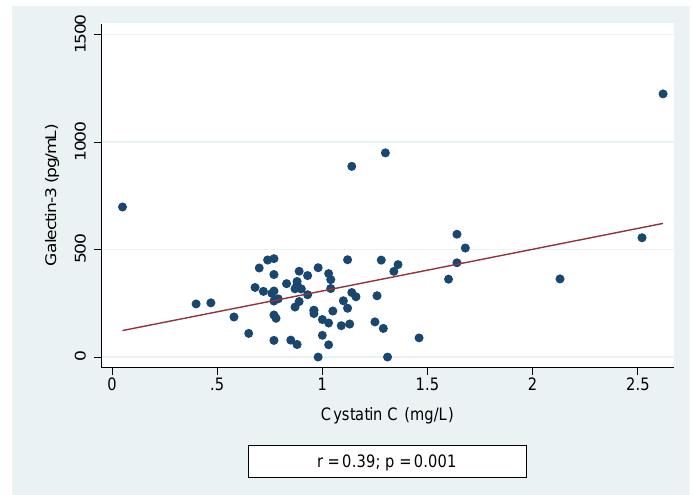
Figure 3. Spearman correlation of galectin-3 and cystatin C levels.